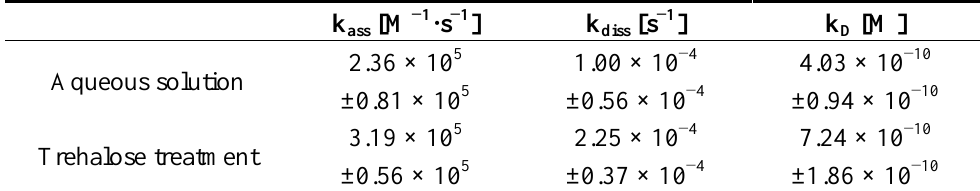
Table 1. Kinetic constants of avidin binding to POPC/Biotinyl-PE membranes detected by QCM. The preparation of model membranes by LB technology and handling in aqueous solution was compared with a drying step in presence of trehalose. Since the latter